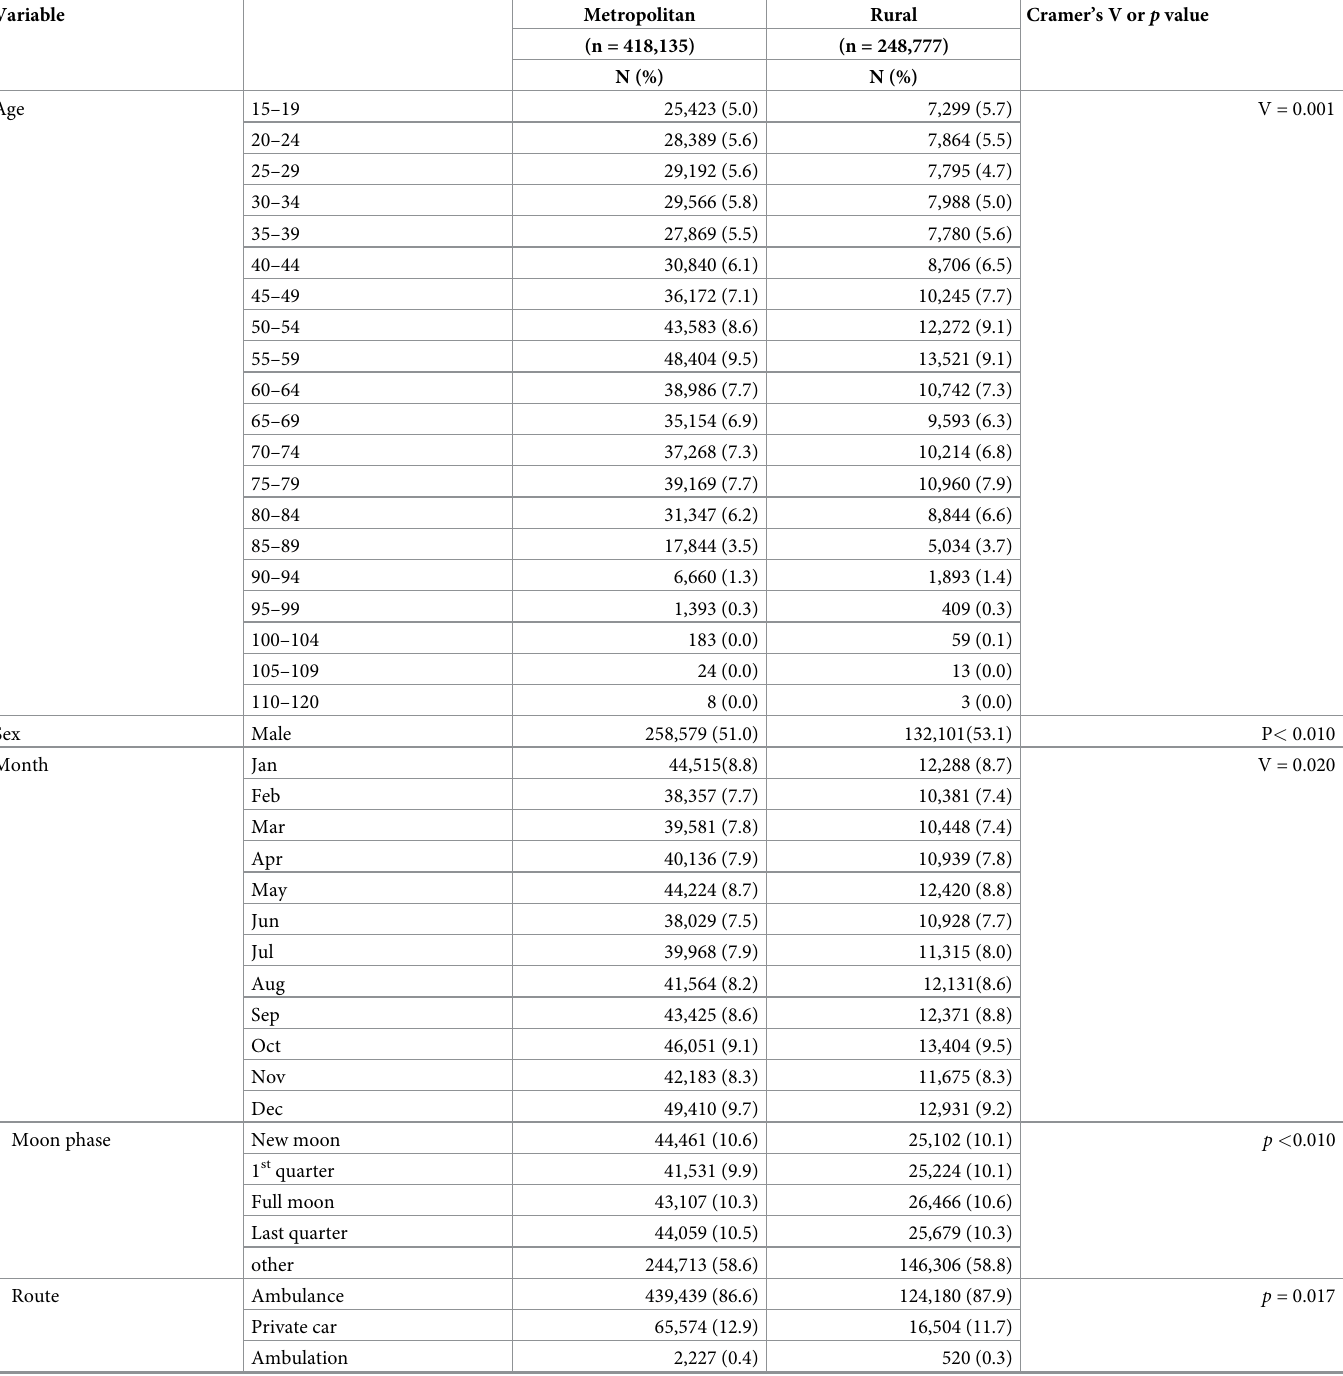
Table 1. Demographic features of subjects who visited ED after a fall